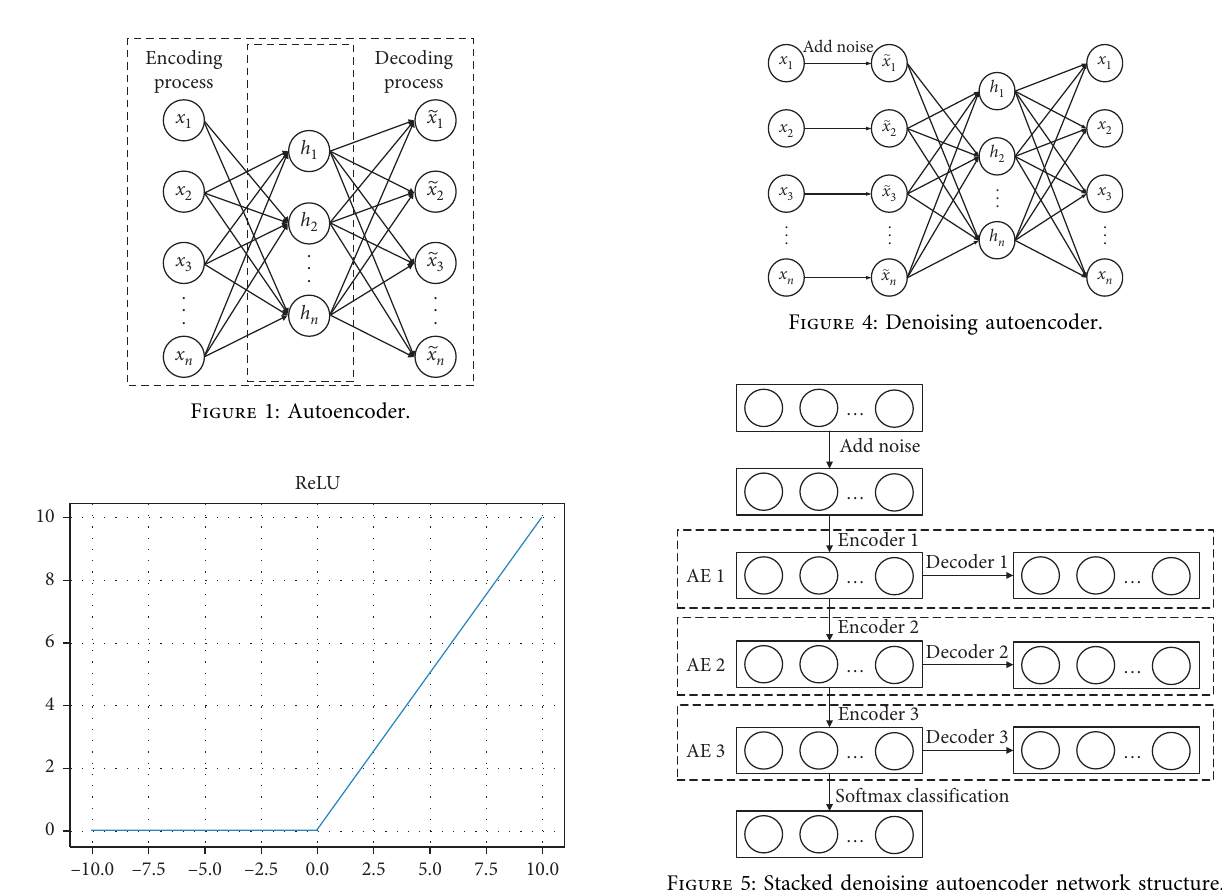
Figure 2: ReLU activation function.